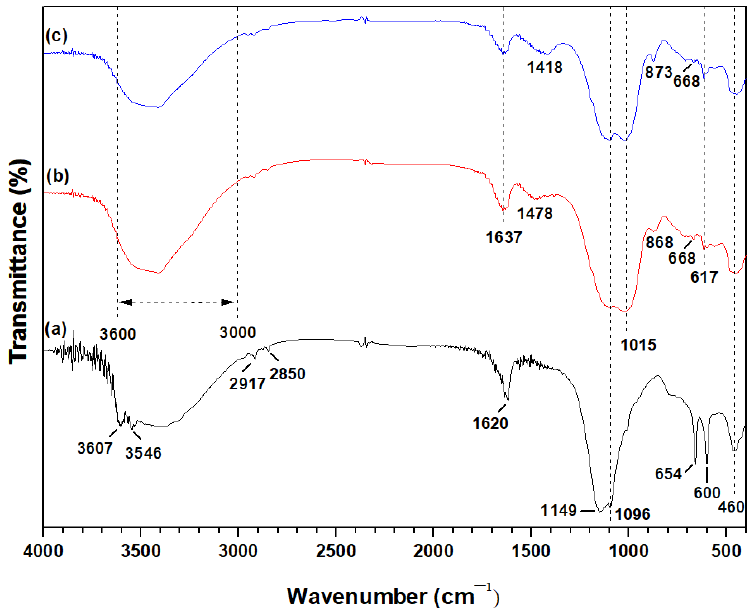
Figure 4. FTIR spectra of (a) leaching residues PLR, (b) PLR50MK50 and (c) PLR70MK30